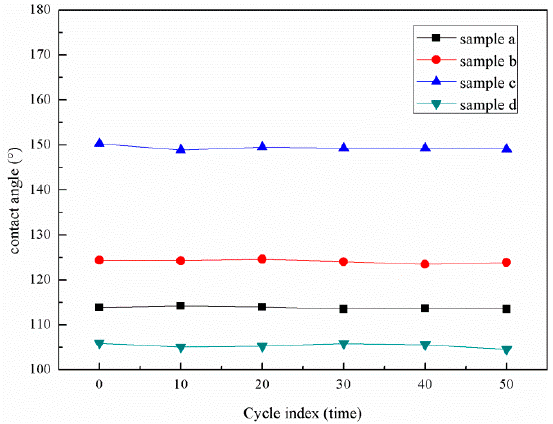
Figure 7. Effect of alternating high and low temperatures on the hydrophobicity of the samples.